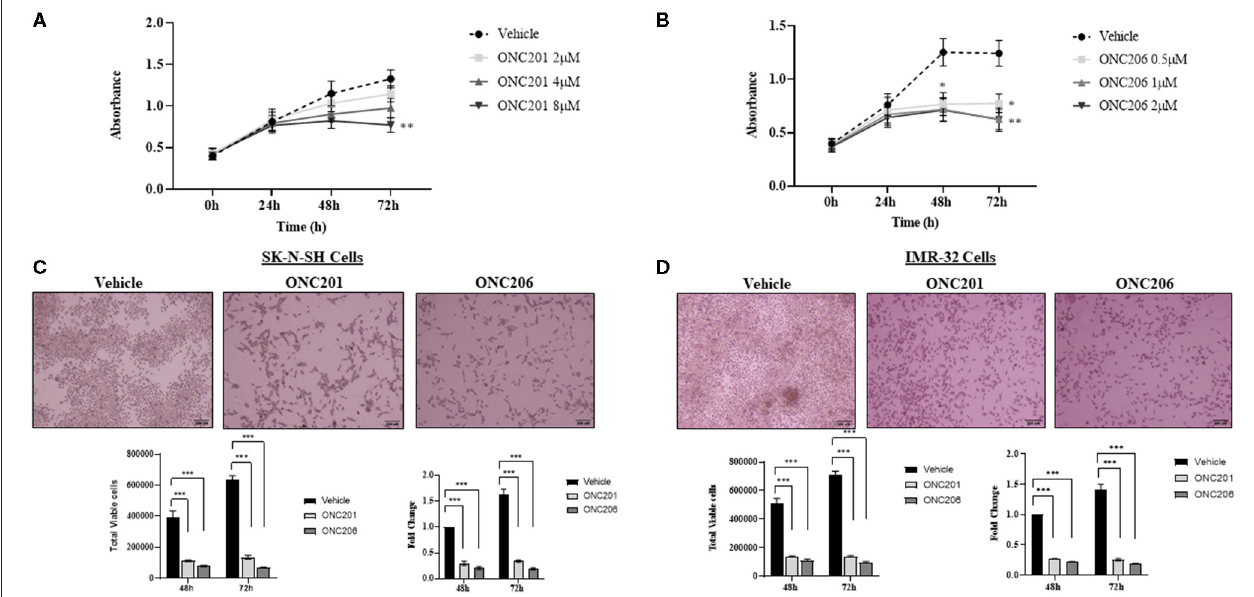
FIGURE 2 | Cellular proliferation and viability inhibited with ONC201/ONC206 treatment. IMR-32 cells treated with increasing doses of either ONC201 (A) or ONC206 (B) exhibited a dose- and time-dependent decrease in cellular proliferation compared with vehicle-treated cells. SK-N-SH (C) and IMR-32 (D) cells treated with either